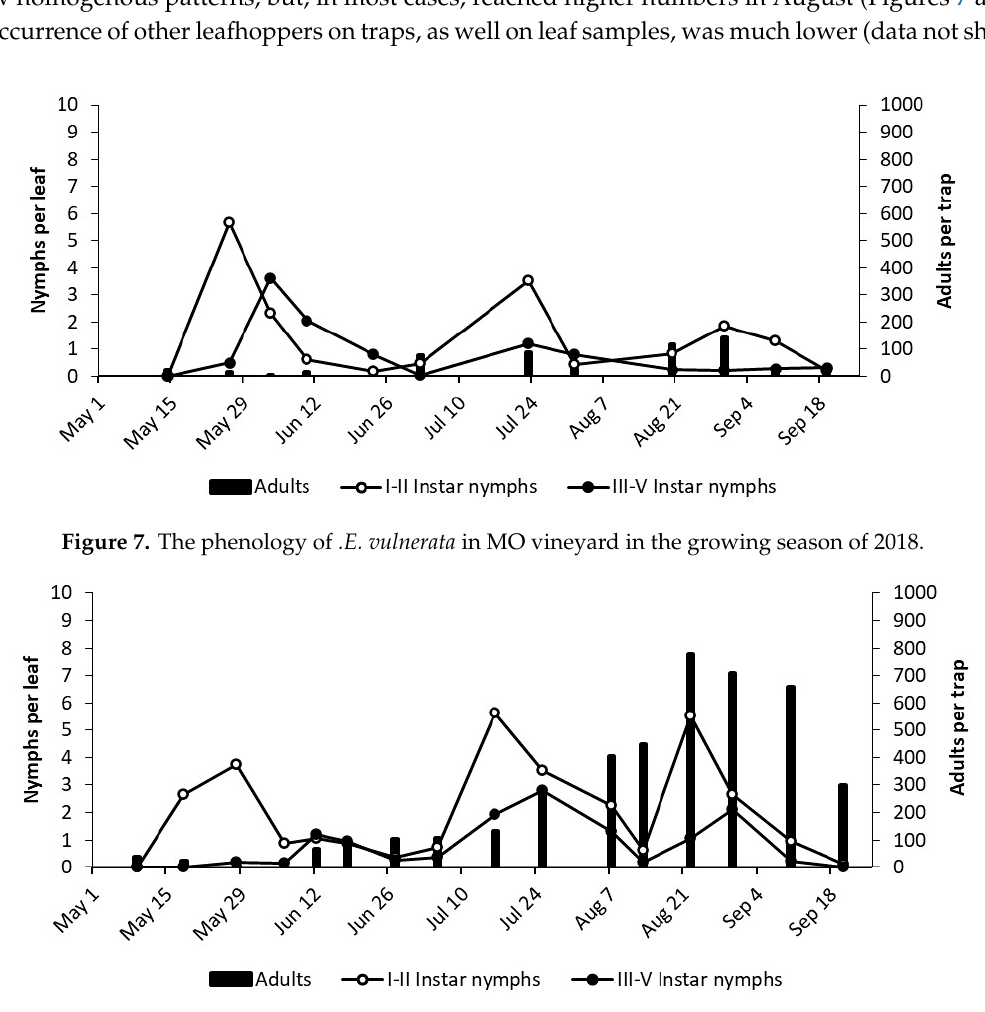
Figure 8. The phenology of E. vulnerata in LO2 vineyard in the growing season of 2018.